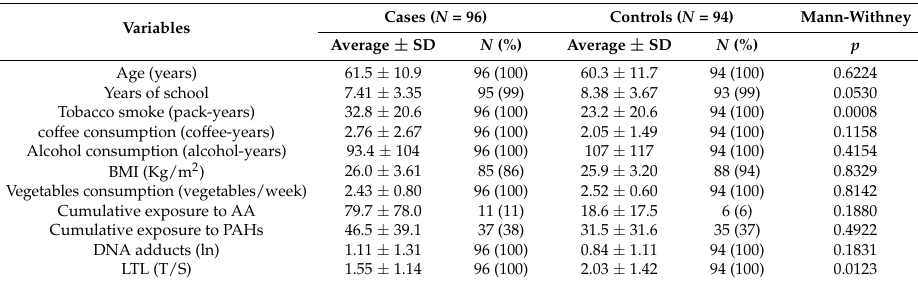
Table 1. Characteristics of the study